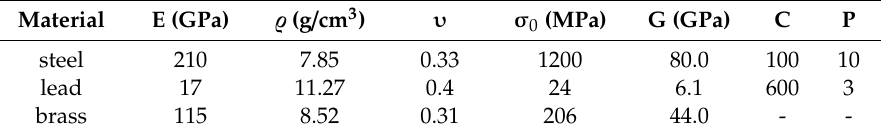
Table 2. Material constants of the steel core, lead jacket, and brass jacket.